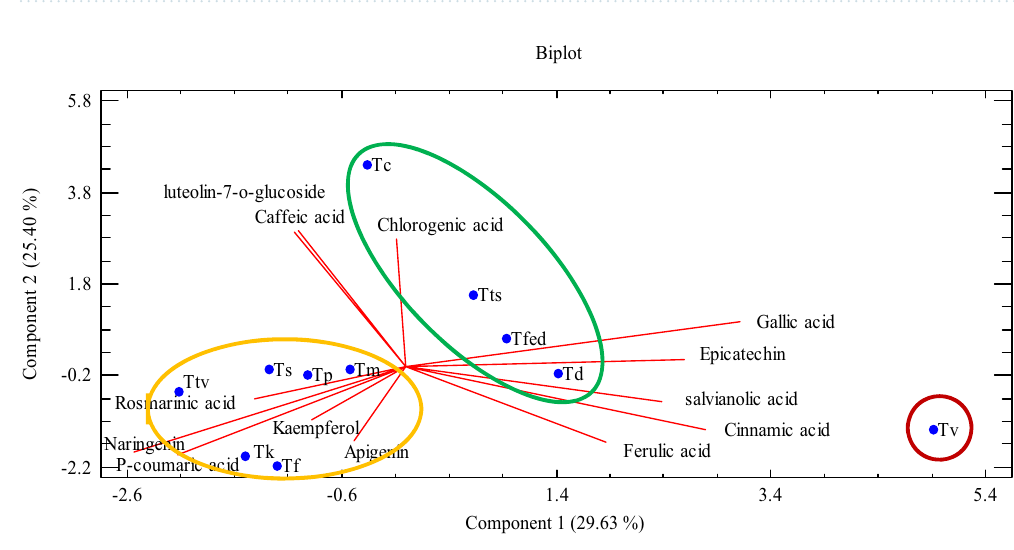
Figure 3. Classification of studied Thymus species according to major polyphenolic